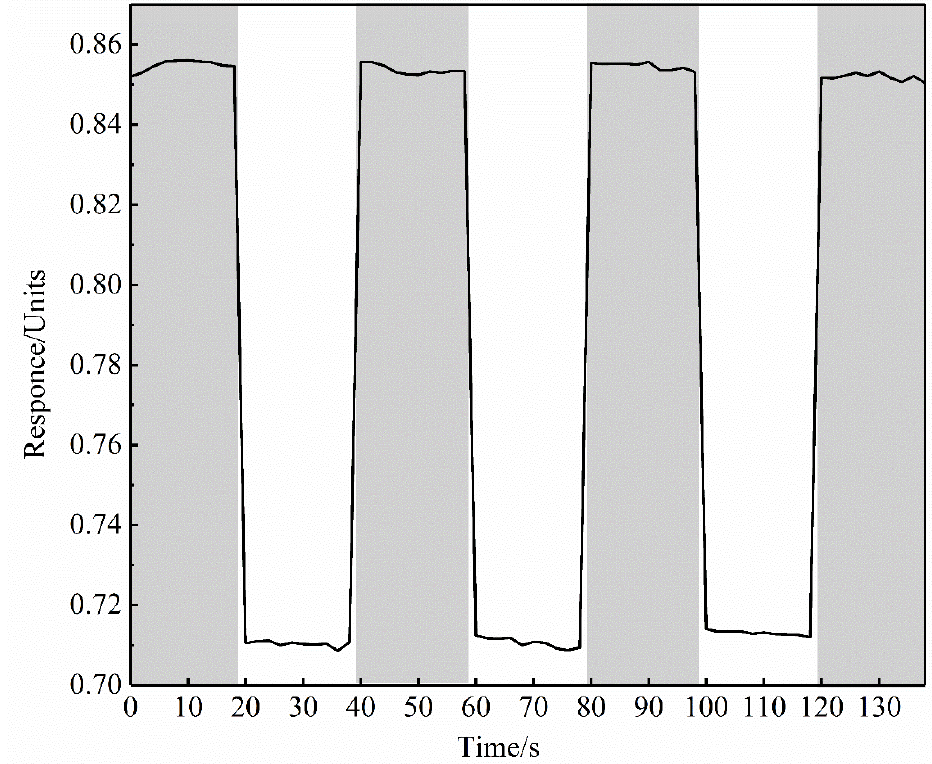
Figure 4. On-off response of helium and argon. The light gray area is argon and the white area is helium.